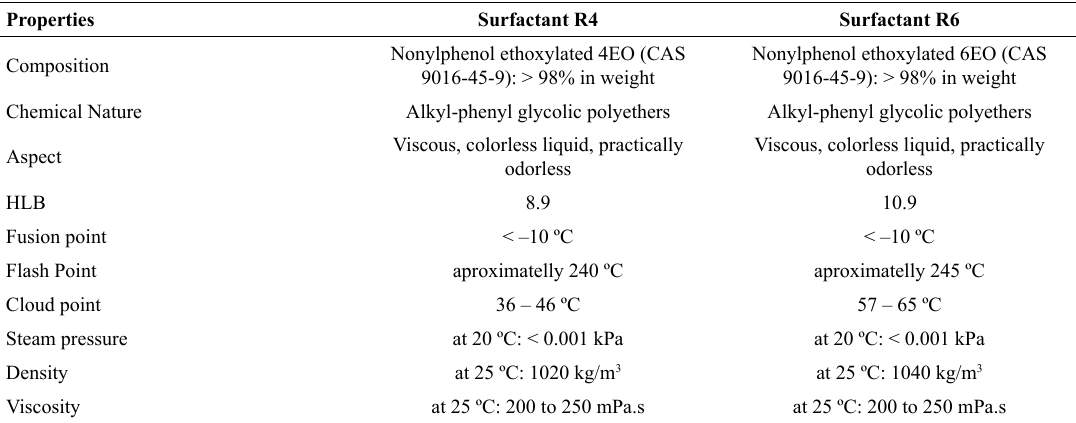
Table 1. Composition and physical-chemical properties of surfactants.